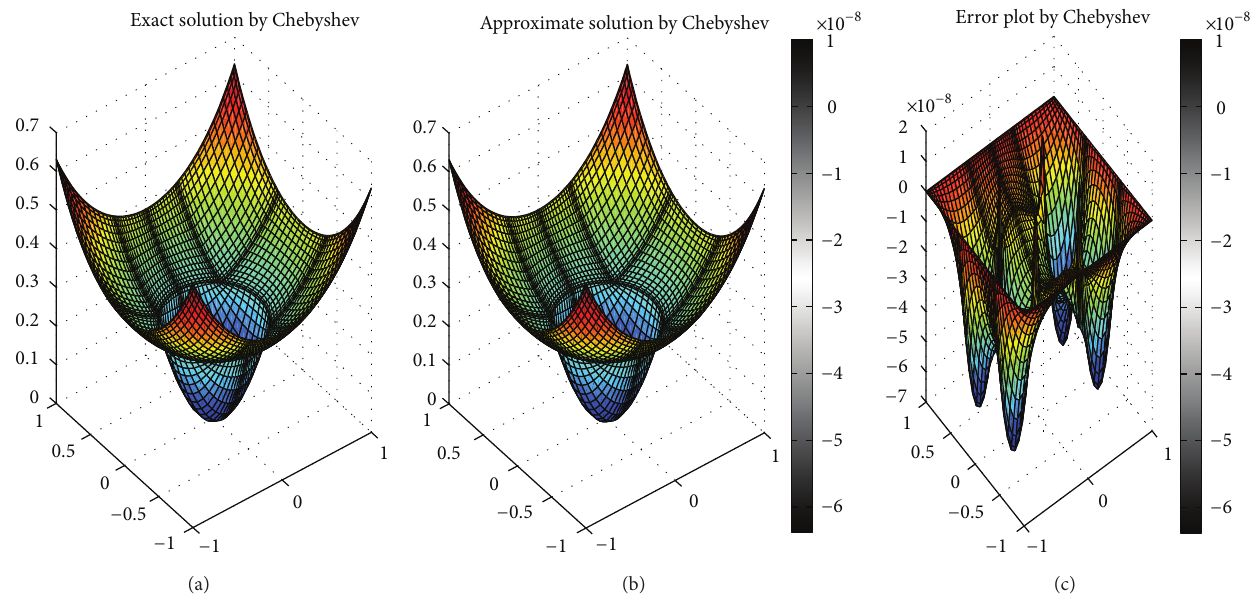
Figure 6: Exact solution, approximation solution, and its error for 𝐶 = 0.1 and 𝑏 = 10 .